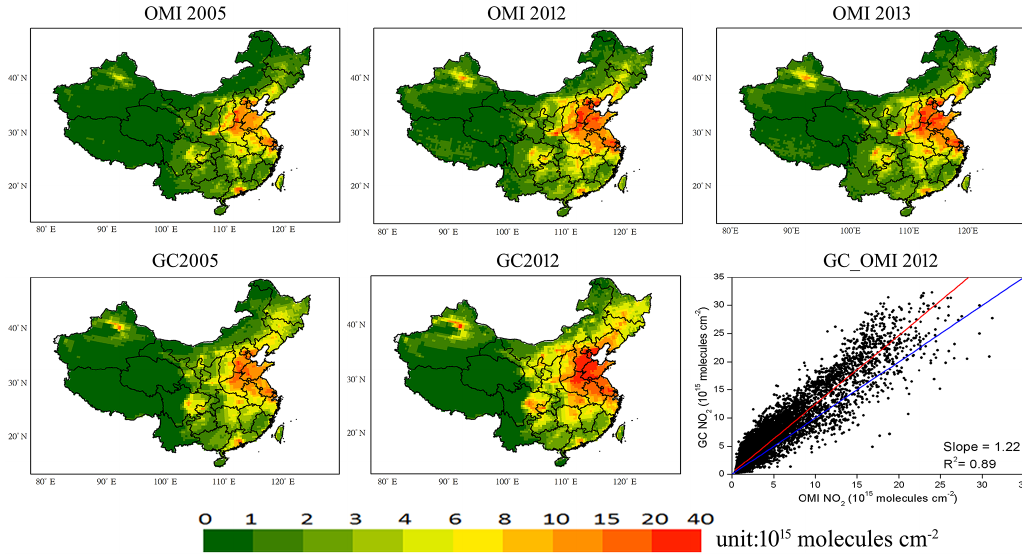
Figure 4. Annual mean OMI NO 2 VCDs over China in 2005, 2012 and 2013, annual mean GEOS-Chem NO 2 VCDs in 2005 and 2012, and a scatterplot with linear regression for model vs. OMI NO 2 in 2012. In the scatterplot, the red line represents a linear fit, and the blue line is the 1:1 line. Table 2. Linear regression for GEOS-Chem modeled annual mean NO 2 VCDs as a function of OMI values over China and Western China.